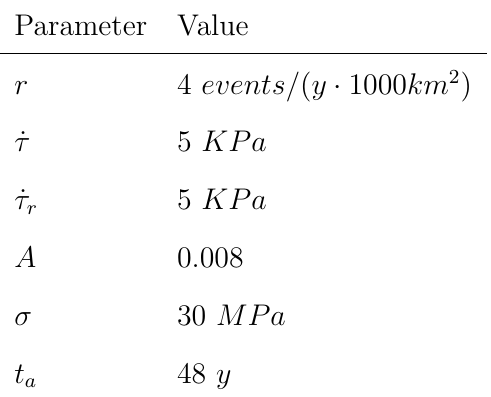
Table 3: Values of the parameters used in the numerical applications of the model for induced